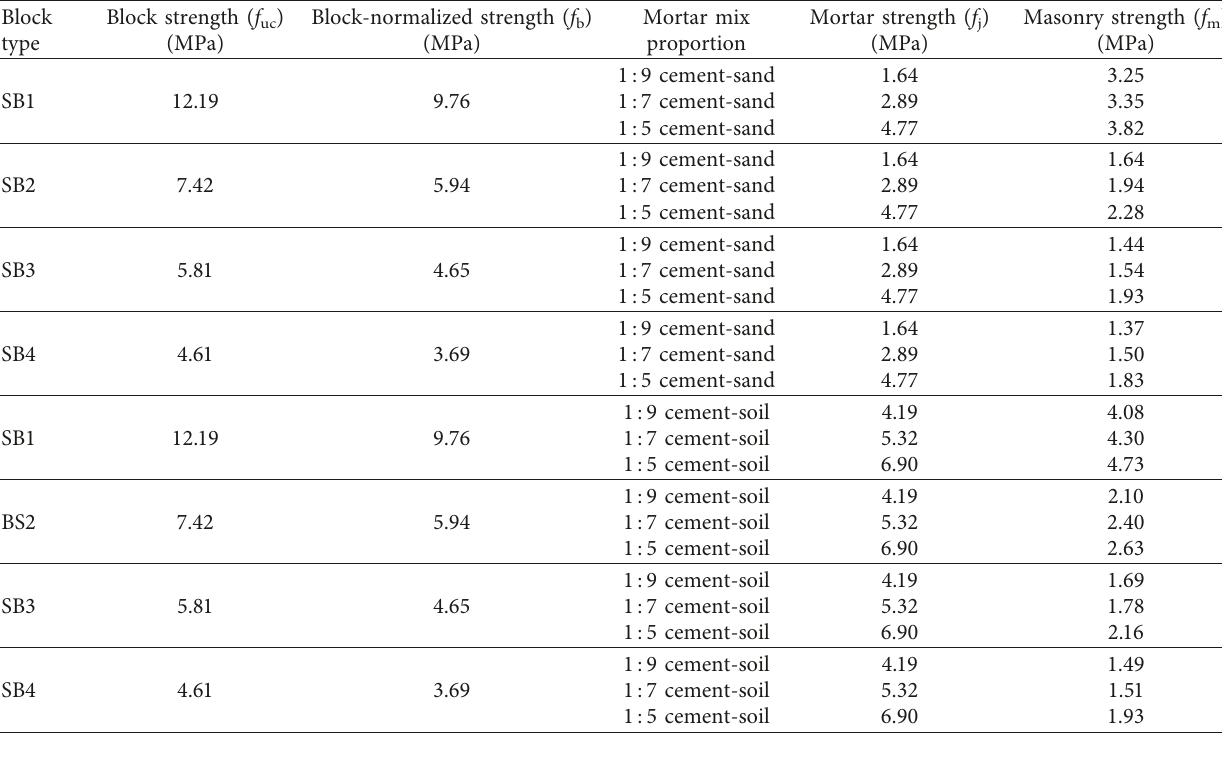
Figure 4: Compressive strength variation of masonry prisms with different blocks and cement-sand mortar combination. Table 6: Mechanical properties of the blocks, mortars, and masonry